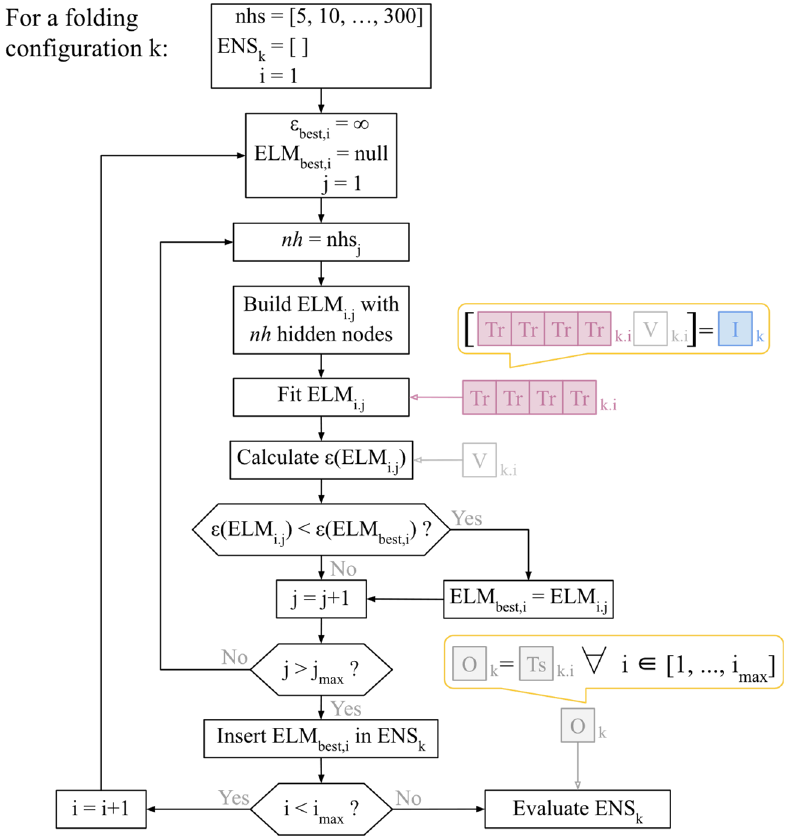
Figure 6. Diagram representing the methodology for training, selecting and evaluating the ELM members of ensemble k. ε ( 𝑥 ) indicates the validation error of the ELM model 𝑥 , nhs i indicates the i-th item in the sequence of assessed number of hidden nodes nhs., ENS k is the ensemble of models k.